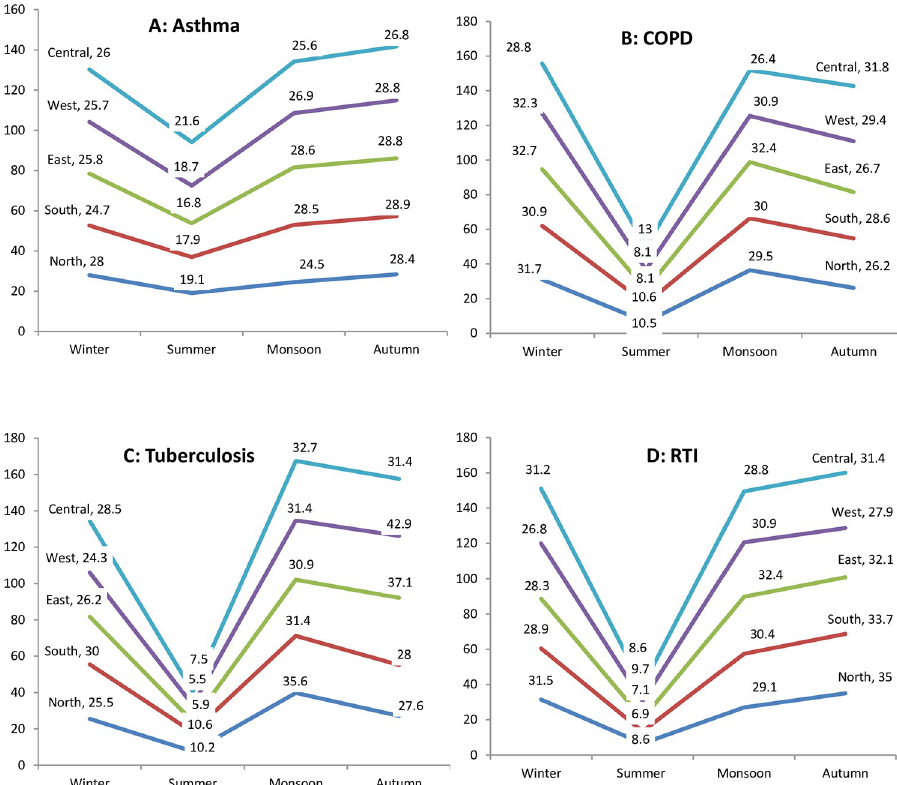
Fig 8. Seasonal patterns of respiratory diagnoses in major geographic zones of India. Regional distribution of seasonal trends for asthma, COPD, tuberculosis, and respiratory tract infections (RTIs), in the north, south, east, west and central regions respectively. The height of the boxes represents proportionate clinical burden and the ribbon over the top of boxes represents seasonal fluctuations. Summer dip are noticeable for all major respiratory diagnoses across the regions (p value <